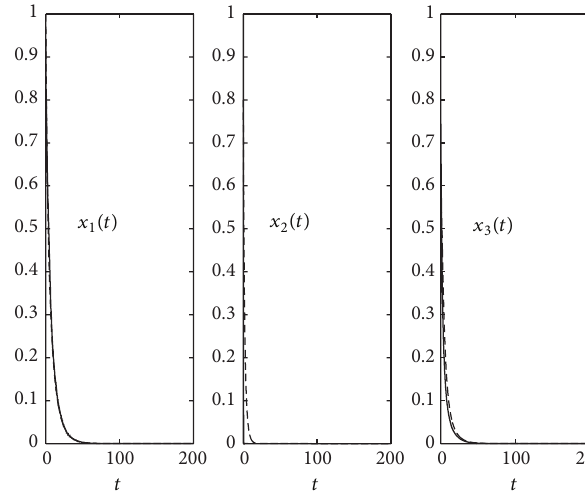
Figure 1: The solution of system (1) and system (3) with (0), 𝑥 (0),𝑥 (0)) = (1,0.8, 0.5) , 𝑎 = 0.3 , 𝑎 = 0.4 , 𝑎 = 0.1 , (𝑥 1 2 3 1 2 3 = 0.1 , 𝑏 = 0.1 , 𝑏 = 0.6 , 𝑏 = 0.6 , 𝑏 = 0.6 , 𝑏 = 0.8 , and 𝑏 11 12 21 22 23 32 = 0.6 . The red lines represent the solution of system (1), while 𝑏 33 the blue lines represent the solution of system (3) with 𝜎 1 = 0.02 , = 0.01 , and 𝜎 = 0.01 . 𝜎 2 3